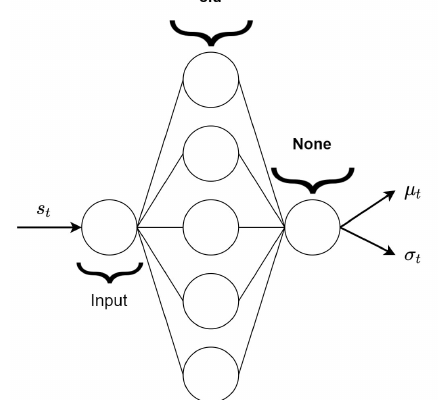
Figure 3. Critic structure.